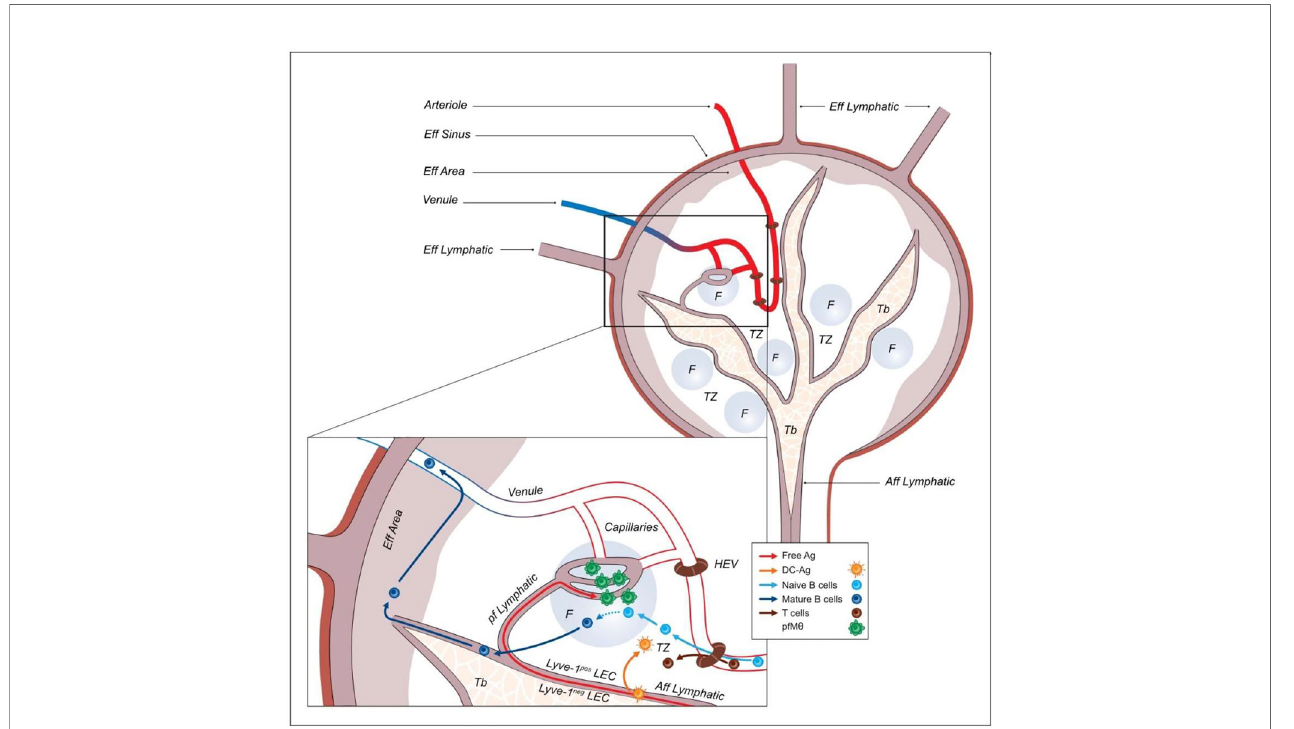
FIGURE 7 | Schematic depicting of the lymphatic and blood fl ow according to immune cells compartments. Aff Lymphatic, Afferent lymphatic; Tb, Trabeculae; F, follicle; TZ, T cell zone; Eff Area, efferent area; Eff Sinus, efferent sinus; Eff Lymphatic, Efferent lymphatic; HEV, High endothelial venule; LEC, Lymphatic endothelial